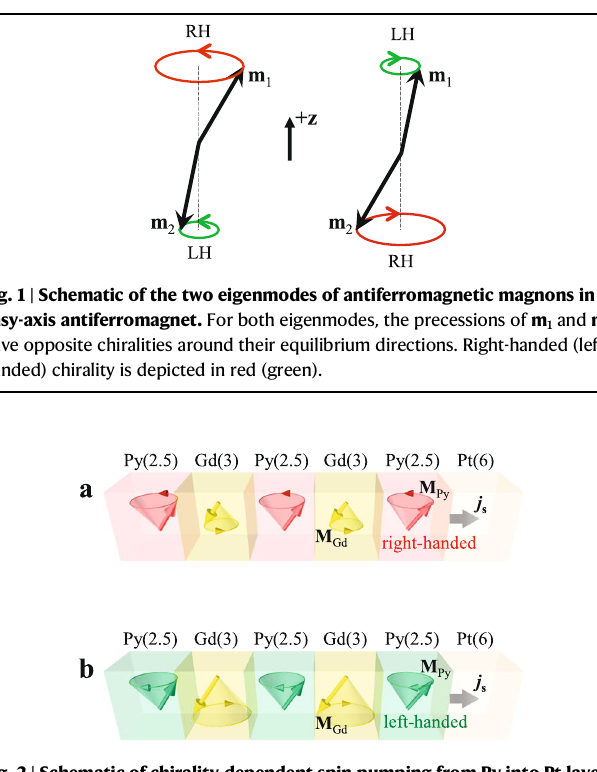
Fig. 2 | Schematic of chirality-dependent spin pumping from Py into Pt layers. The spin current injected into the Pt layer is generated by a right-handed M Py precession in the Py-aligned phase (| M Py |>| M Gd |), and by b left-handed M Py pre- cession in the Gd-aligned phase (| M Py |<| M Gd |). The numbers in parentheses are thicknesses in the unit of